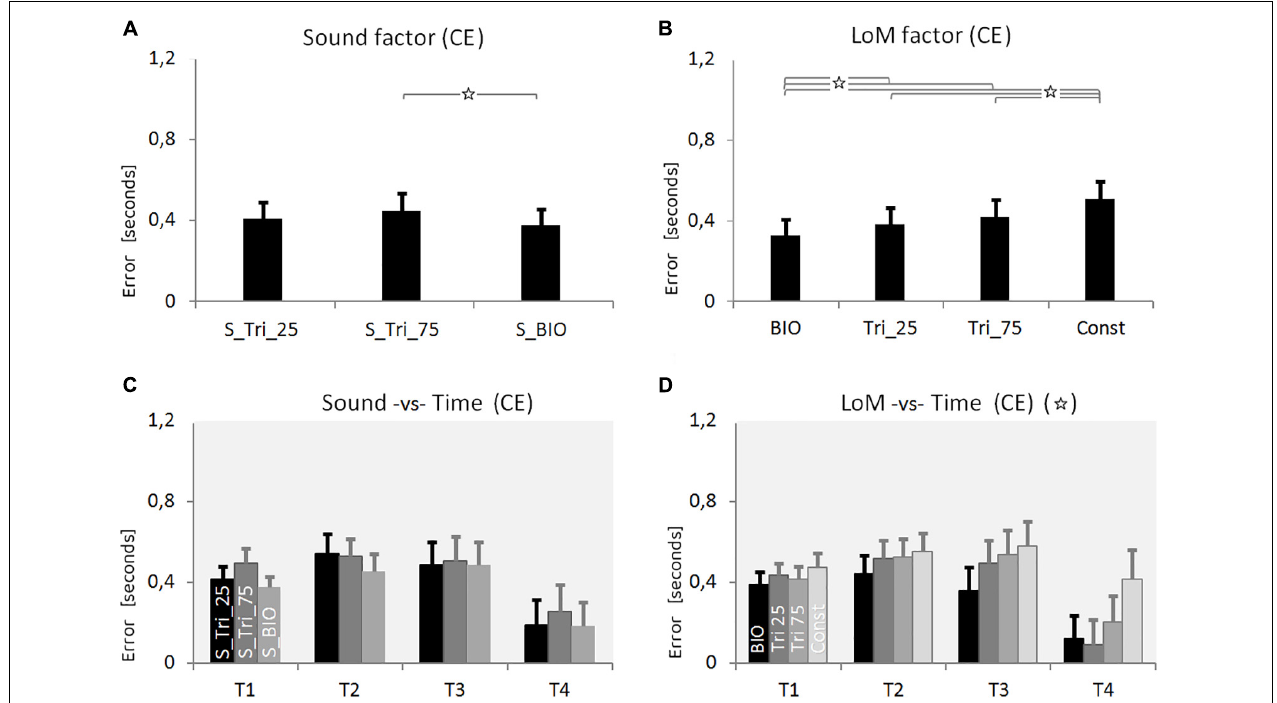
FIGURE 5 | Results of Experiment 3. (A) Constant Error (CE) for the three Sound conditions: S_Tri_25, S_Tri_75, S_BIO (pitch envelopes are presented in Figure 2 and described in the text). (B) CE for the four Laws of Motion (LoM): Biological velocity profile (BIO), Triangular velocity profile with a peak of velocity at 25% of the trajectory (Tri25), Triangular profile with a peak at 75% (Tri75), Constant velocity profile (Const). (C) Interaction between Sound and Time main factors. Each group of bars refers to a different Time condition (T1 = 0.5 s, T2 = 1.0 s, T3 = 1.5 s, T4 = 3.0 s); in each group, bars respectively presents the Constant Error value of the three Sound conditions: S_Tri_25, S_Tri_75, S_BIO (respectively black, dark-gray and light-gray color). (D) Interaction between LoM and Time main factors. For each Time conditions (T1 = 0.5 s, T2 = 1.0, T3 = 1.5, T4 = 3.0) bars represent the Constant Error of the LoM conditions (from the black to the light-gray bar, respectively: BIO, Tri25, Tri75, Const). For all of the charts: Y -values are in seconds, error bars represent standard errors of the mean, and stars indicate significant statistical differences (when the star is in the headline, please refer to the text for details regarding the statistical differences between conditions).